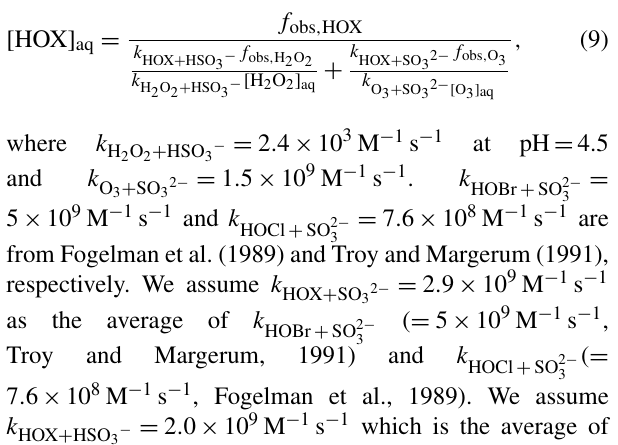
3f shows the comparison between (cid:49) 17 O mod ( nssSO 2 − ) and (cid:49) 17 O obs ( nssSO 2 − 4 cloud pH simulation. Overall, (cid:49) 17 O mod ( nssSO 2 − (cid:49) 17 O obs ( nssSO 2 − ) much better than the standard run, espe- 4 cially for samples over Southern Ocean. (cid:49) 17 O mod ( nssSO 2 − ranges from 0.4 to 2.4 ‰, with an average of 1.1 ± 0.5 (1 σ) ‰. In comparison, (cid:49) 17 O obs ( nssSO 2 − 0.0 to 1.6 ‰, with an average of 0.7 ± 0.4 (1 σ) ‰. The difference between averaged (cid:49) 17 O mod ( nssSO 2 − (cid:49) 17 O obs ( nssSO 2 − ) (0.4 ‰) is just slightly larger than 4